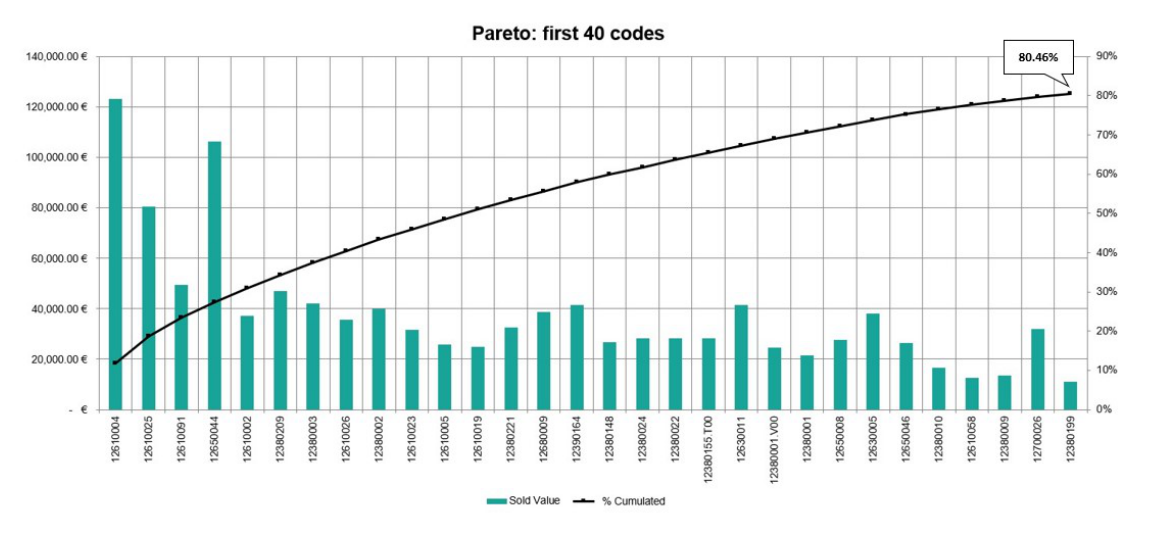
Figure 3. Pareto graph of orders made, expressed in Euros.